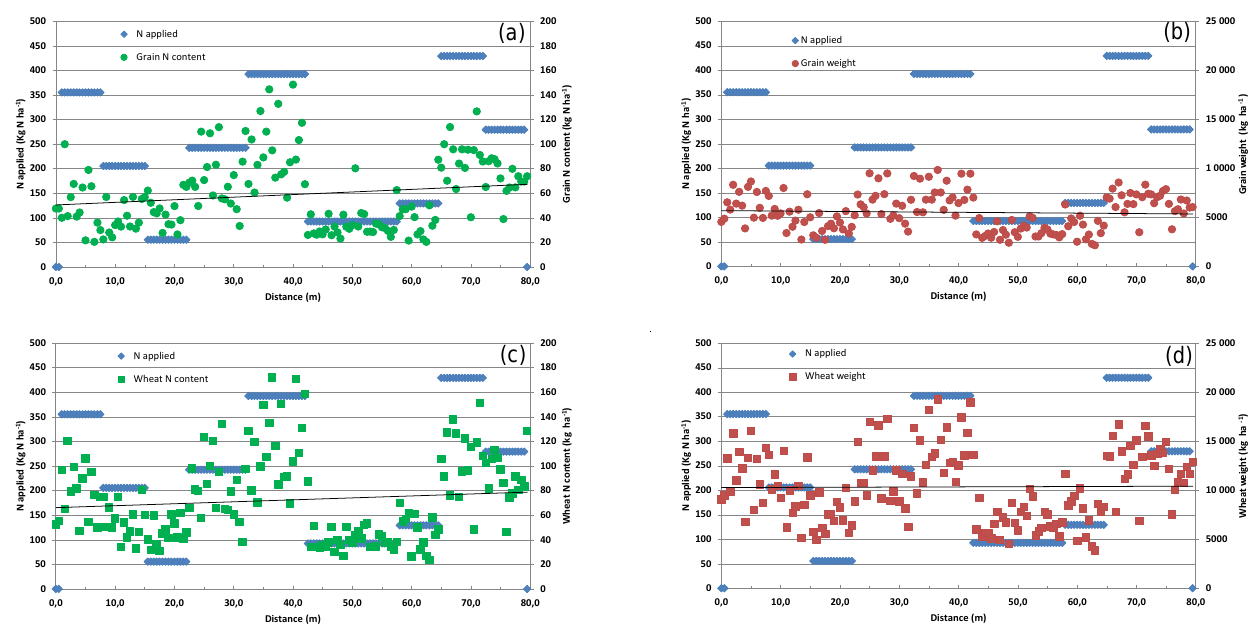
Figure 3. Original data of the four variables studied, including the nitrogen doses applied in the melon crop along the transect: (a) grain nitrogen content (GN), (b) grain weight (GW), (c) wheat nitrogen content (PN) and (d) wheat weight (PW). Black lines represent the trend of each variable versus distance (see Table